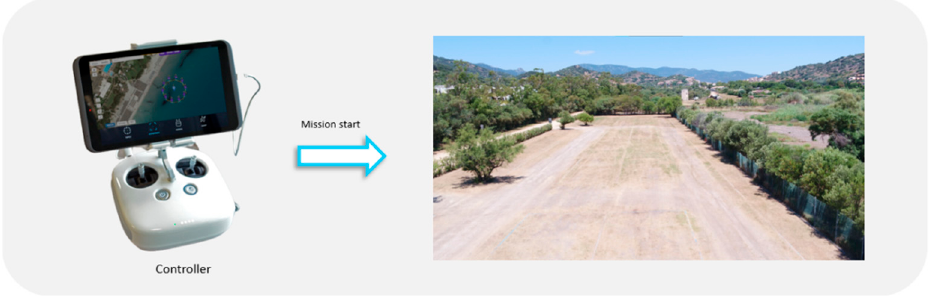
Figure 7. Loading the mission on Litchi.